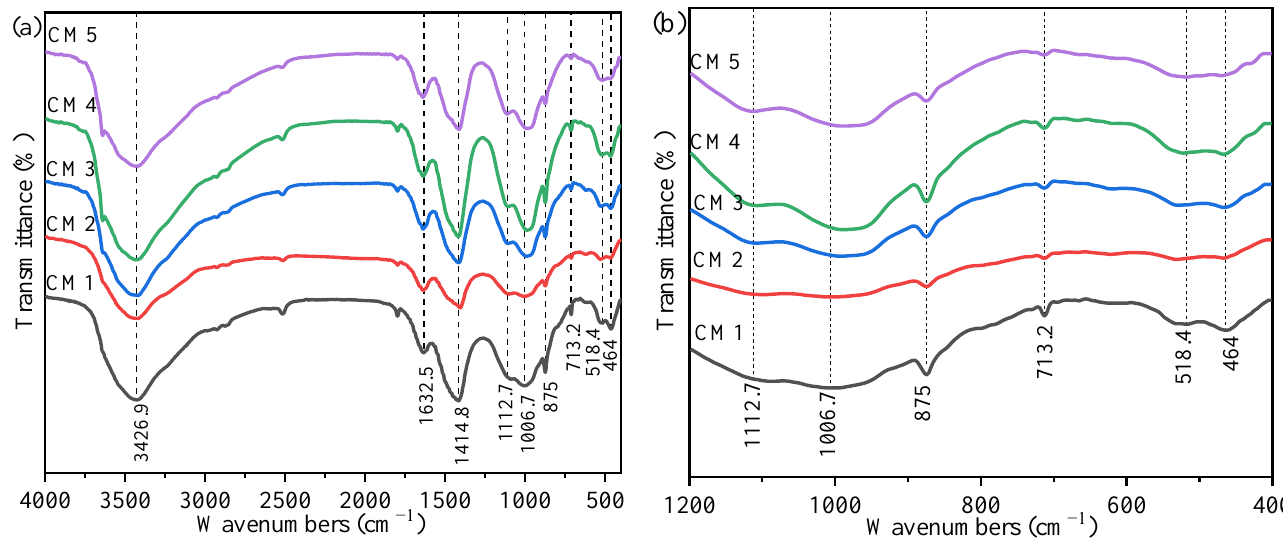
Figure 4. FTIR spectra of sample CM1 to CM5 ( a , b ). Table 3. Peaks detected by FTIR spectroscopy and the corresponding functional groups.